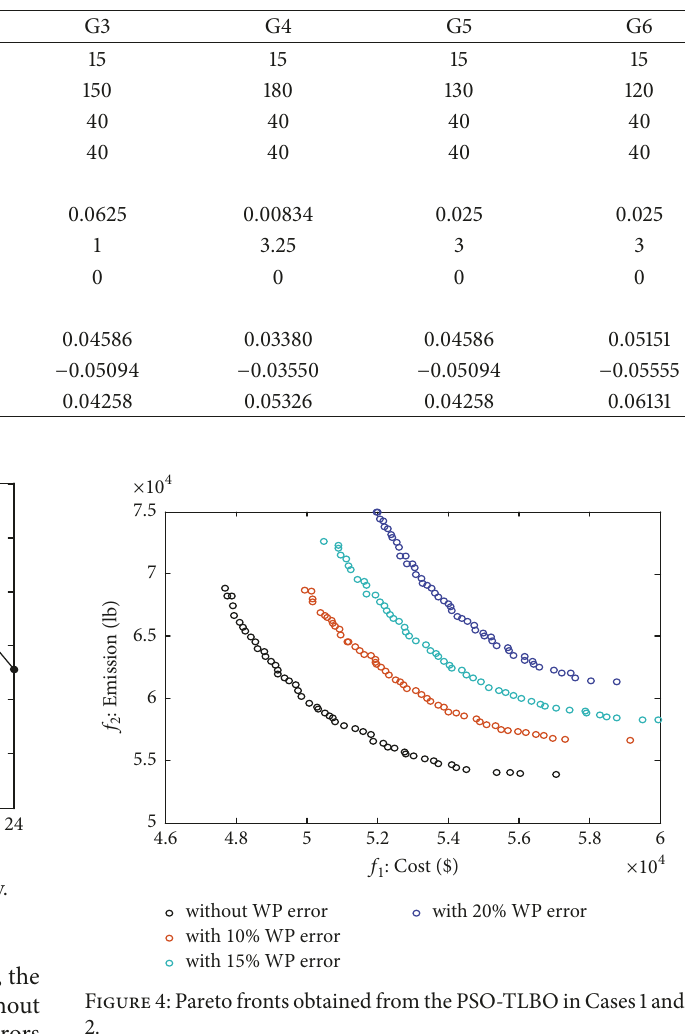
EED has to schedule with more costs and emissions when dealing with the uncertainty of the